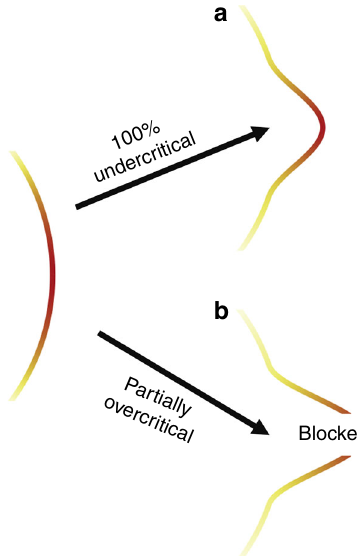
Fig. 5 Linear Paul trap: 3D view of the employed Paul trap. Trap electrodes are shown in red. The distance between the end cap electrodes can be adjusted to account for different target sizes and materials (20 mm in the presented experiment)